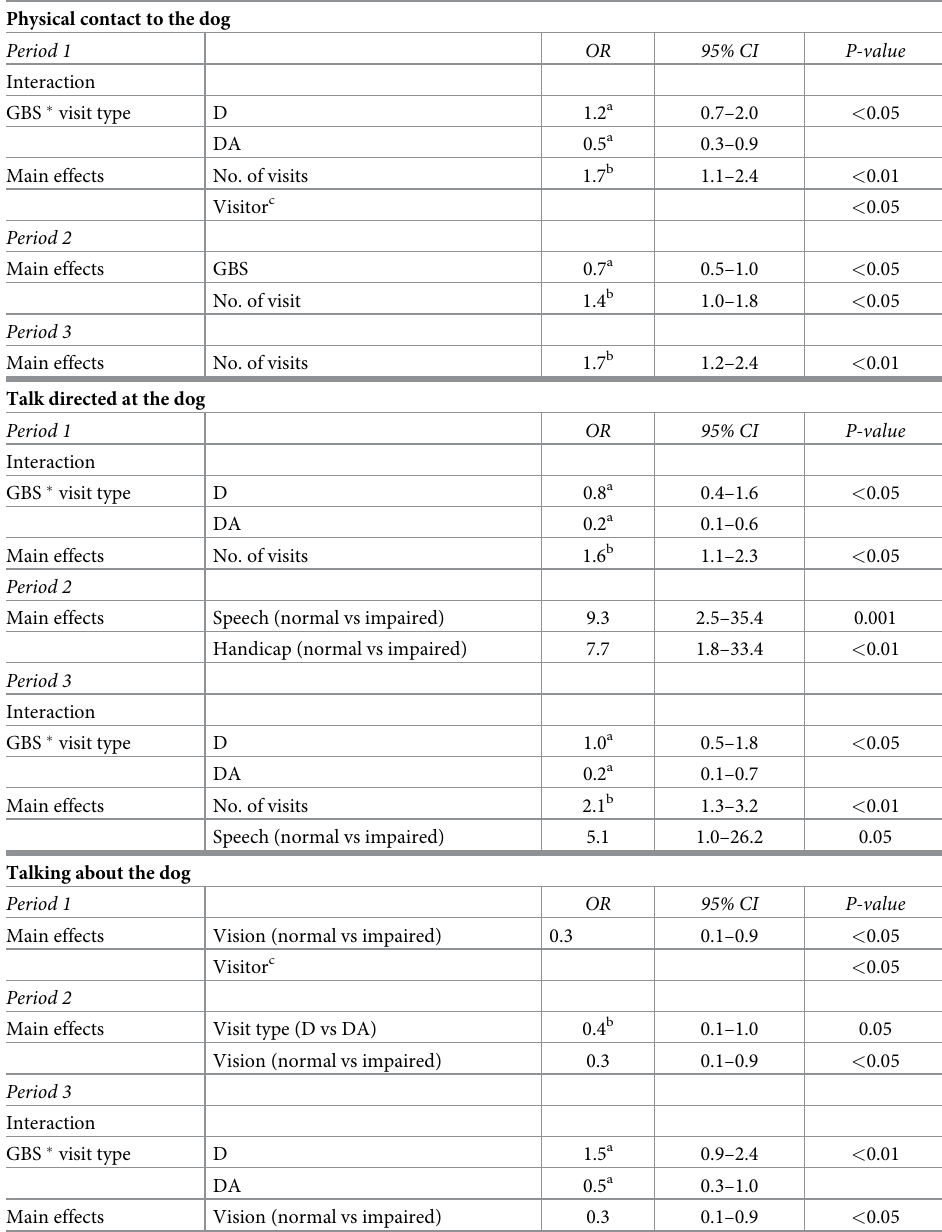
For each of the three periods, the estimated odds ratios (OR), the 95 confidence intervals (95% CI) and the P-values are shown for significant effects. Visits with a dog, no activity (D), Visits with a dog, with activity (DA), The Gottfries-Br å ne-Steen Scale (GBS).